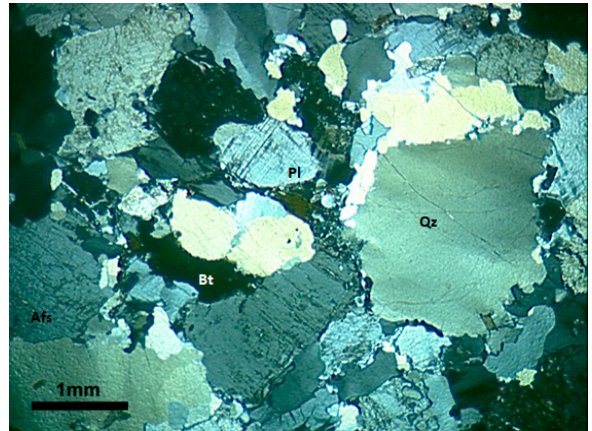
Figure 1. General aspect of the matrix of granite M1 subjected to low deformation rates. Microstructures observed in quartz grains are mainly undulatory extinction, deformation bands, and the formation of subgrains, especially in the large igneous quartz grain boundaries. Optical microscope under crossed polarizer. Afs = K-feldspar, Qz = quartz, Pl = plagioclase, and Bt = biotite.